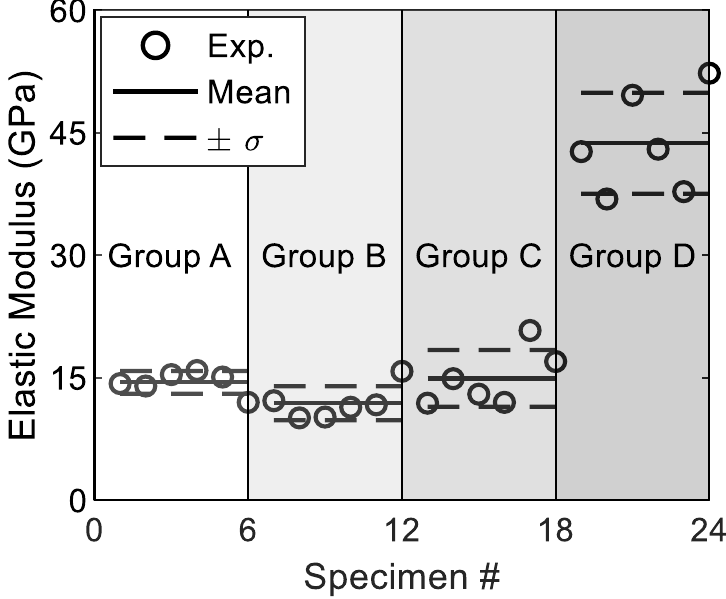
Figure 11. Elastic moduli (note: σ denotes standard deviation).